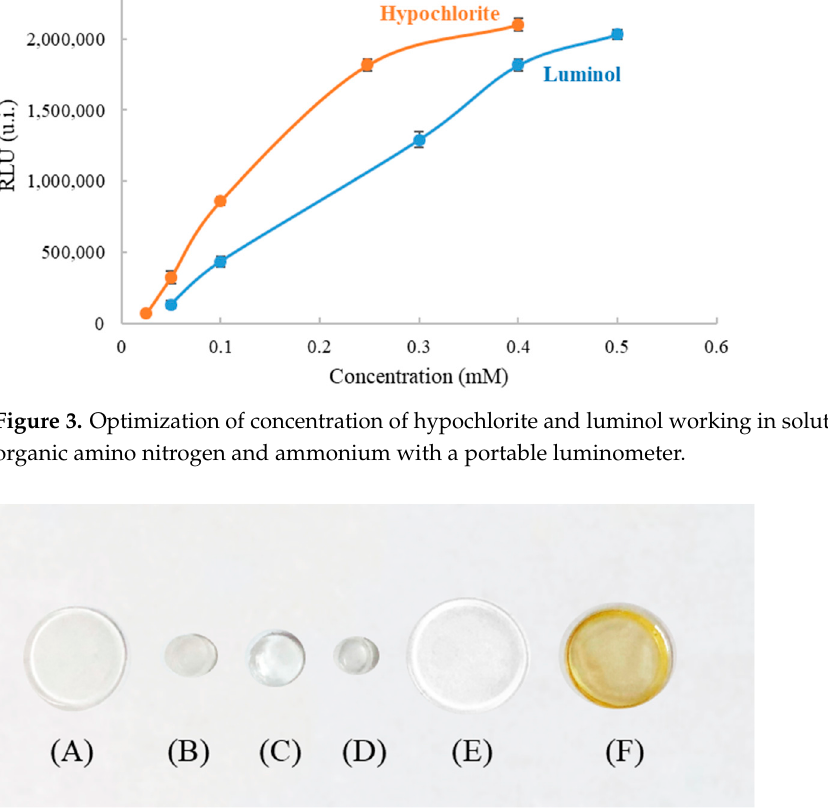
Figure 5. ( A ) Developed TEOS/MTEOS sol–gel sensor in the polystyrene tube. ( B ) % of remaining activity in the developed devices at different time to heat the device in the oven at 40 °C. ( C ) % reaction inhibition as function of nitrogen concen- tration (7.5 µM and 15 µM).